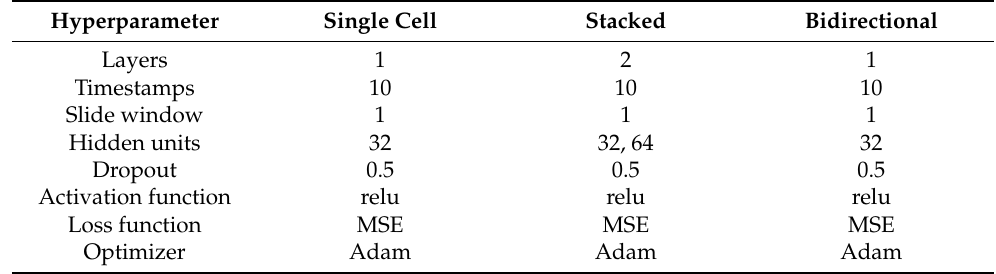
Table 1. LSTM simulation hyperparameters for three